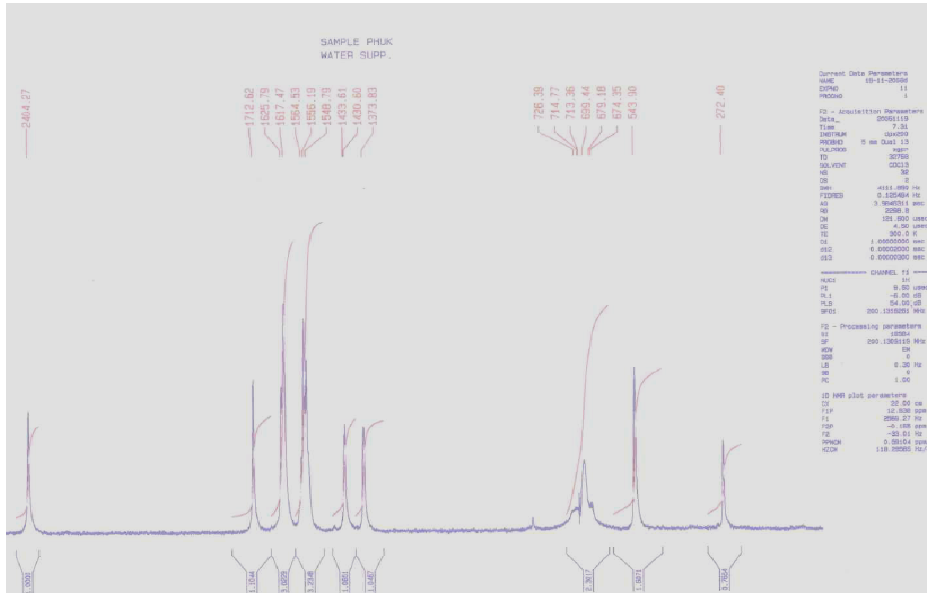
Figure 3. 1 H NMR spectrum of a representative complex [W(CO)